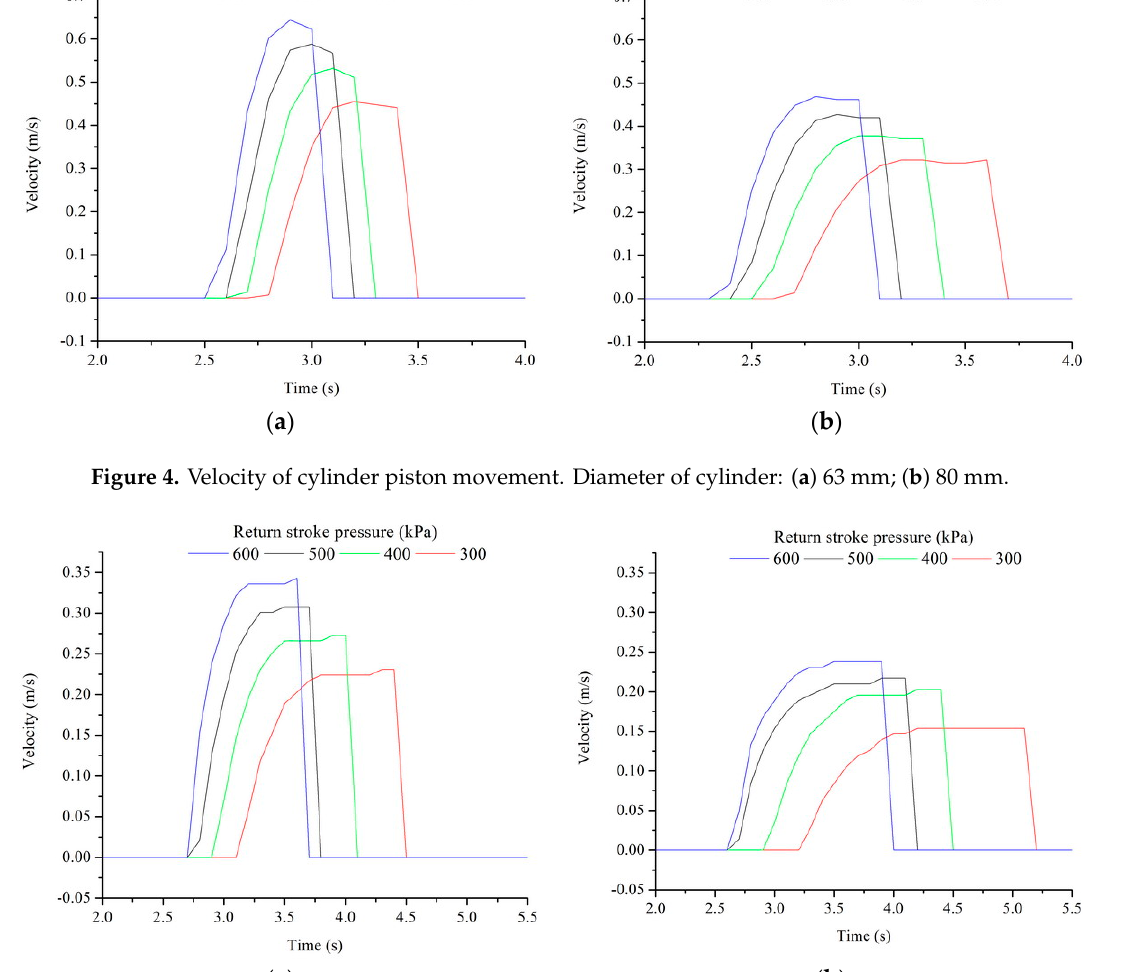
Table 3. The savings in compressed air consumption after second set of measurements.